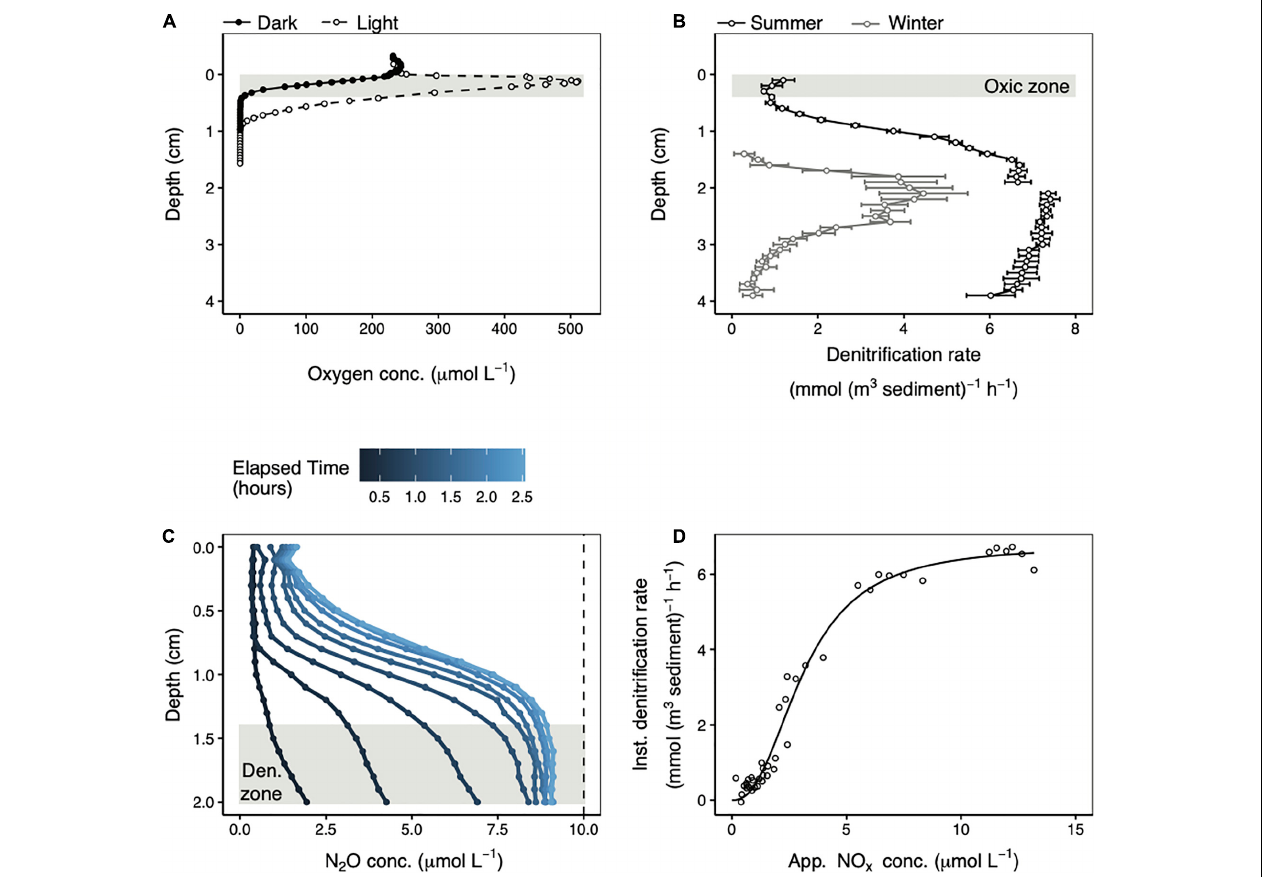
FIGURE 2 | Representative summer steady state oxygen concentration depth profiles in the light (open circles) and in the dark (closed circles) (A) . Potential denitrification rate profiles in the summer (black) and in the winter (gray) measured in the light (B) . Error bars represent the linear regression standard error. The gap in the summer profile reflects two separate measurements made over different depth intervals in the same core. The shaded areas in (A,B) represent the depth interval over which oxygen was always present in steady state profiles. Repeated N 2 O concentration microprofiles following acetylene addition in the summer (C) . The dashed line represents the maximum possible N 2 O concentration that could be generated from the available porewater NO x . The instantaneous potential denitrification rate plotted against the apparent amount of NO x remaining in the porewater (D) over the 1.4–2.0 cm depth range highlighted in (C) . The black line is fit to the data using Equation